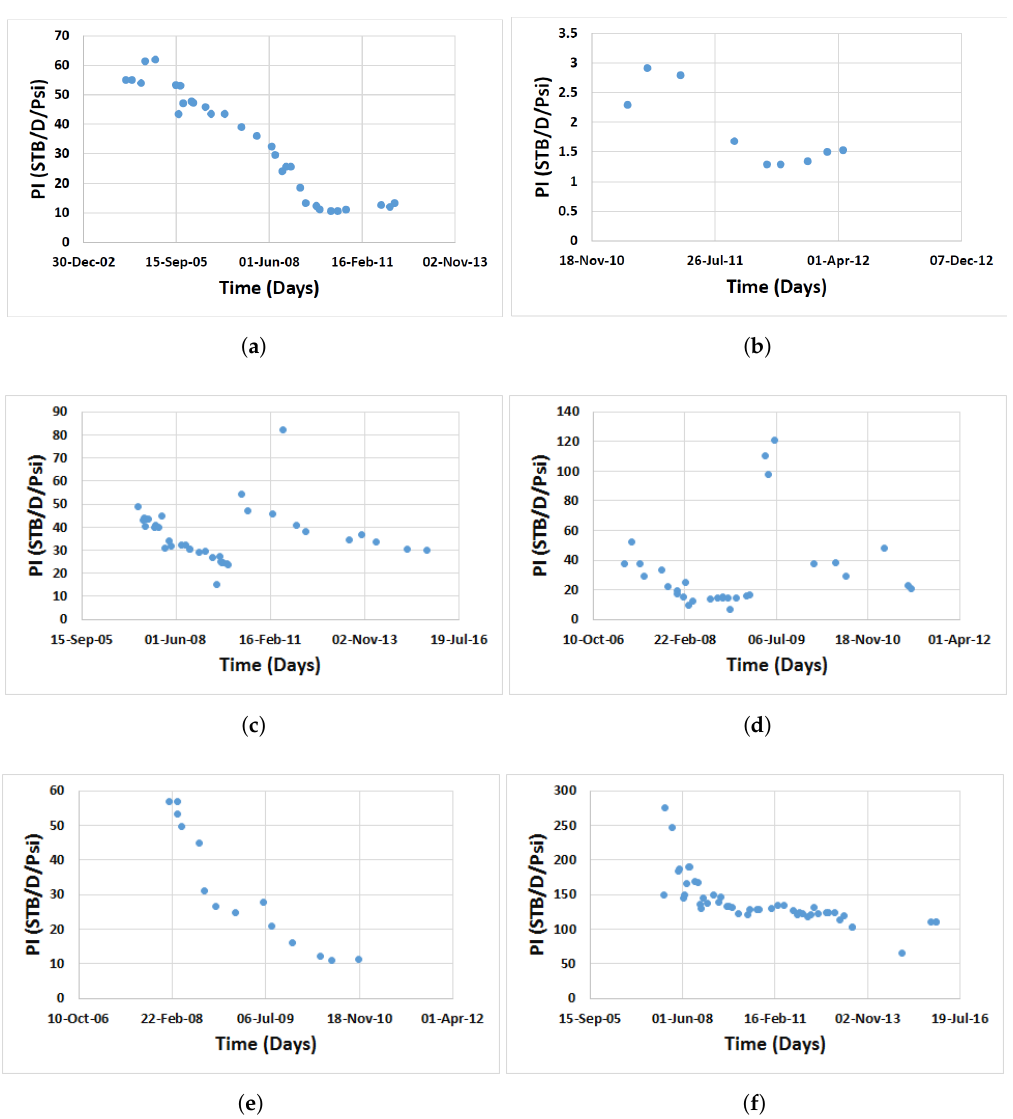
Figure 8. Productivity index for wells ( a ) X6Y13W1; ( b ) X7Y29W4; ( c ) X5Y10W17; ( d ) X5Y11W12; ( e ) X5Y11W24; and ( f ) X7Y24W35. In all cases X indicates the field, Y the reservoir and W the well